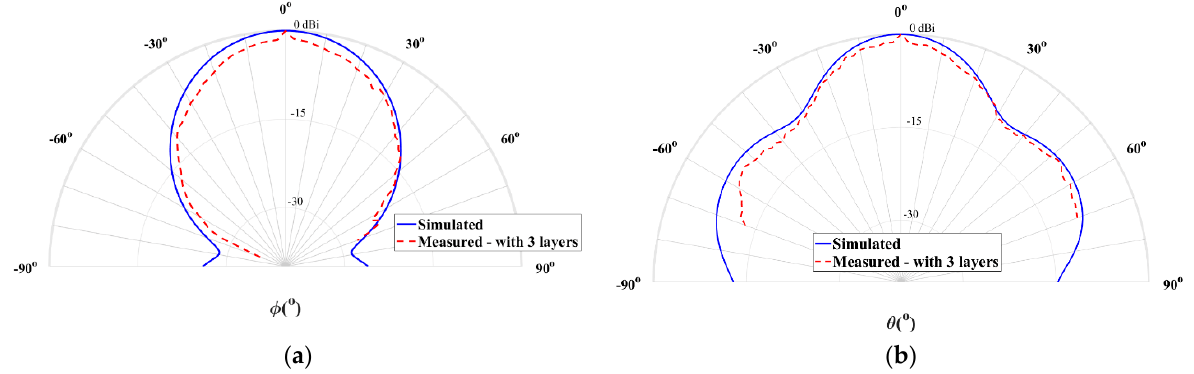
Figure 11. Simulated and measured normalized radiation pattern at 28 GHz of the three-layer horn antenna (sanded) with conductive paint: ( a ) plane θ = 90° and ( b ) plane ϕ = 90°.